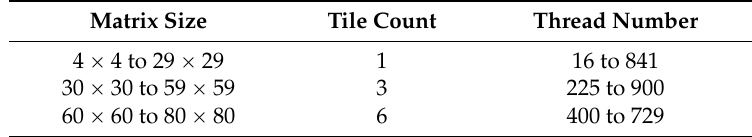
Table 4. Thread number of gpu_Rxx_batched per block for covariance matrices of different sizes. Matrix